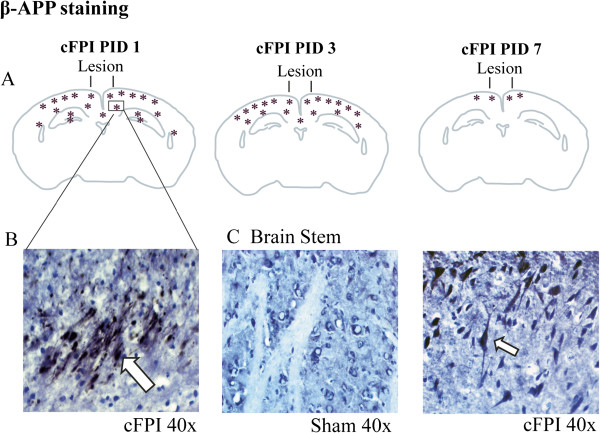
Axonal injury after cFPI in mice shown by β-APP immunostaining. (A) Schematic distribution of the β-APP staining in the various brain regions at 1, 3 and 7 days post-injury; (B) Axonal profiles stained with β-APP in the corpus callosum at 1 day post-injury (for example see arrow); (C) β-APP positive axonal profiles in the brain stem at 1 day post-injury (right; for example see arrow), compared to a sham-injured animal with normal staining of nerve cell bodies (left). PID: Post-injury day.